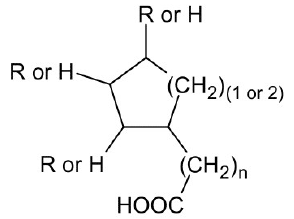
Figure 1. Chemical structure of naphthenic